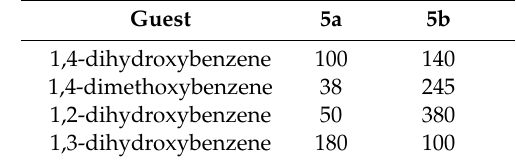
Table 1. Association constant K ass (M − 1 ) for the 1:1 complexes between phenol-containing aromatics and macrocycles 5 measured by UV / Vis titration at 298 K in MeCN 1